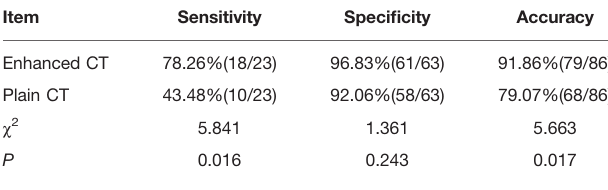
TABLE 4 | Comparison of contrast-enhanced CT and plain CT in the diagnosis of vascular tumor thrombus in lung adenocarcinoma [ n (%)].